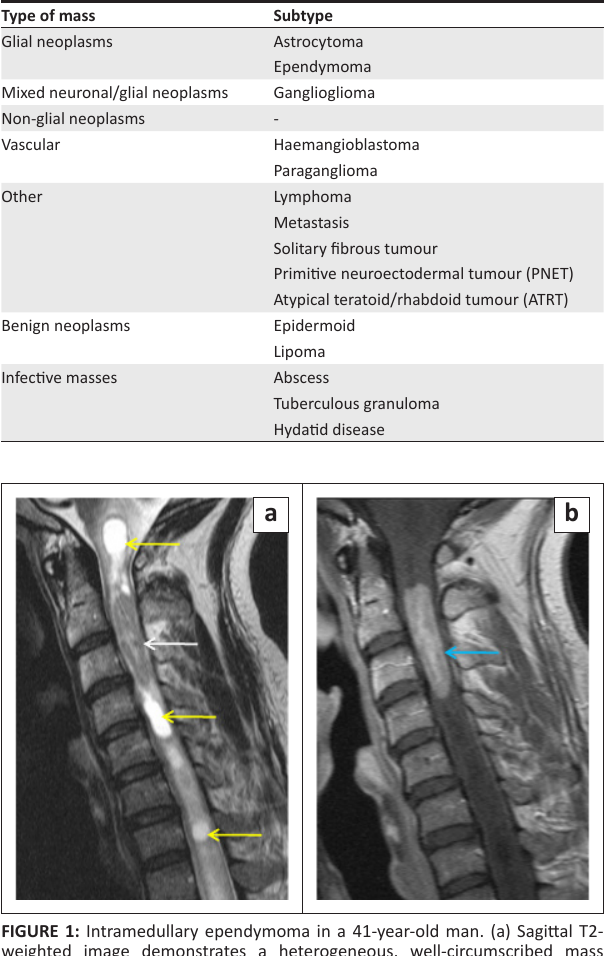
TABLE 1: Intramedullary masses.